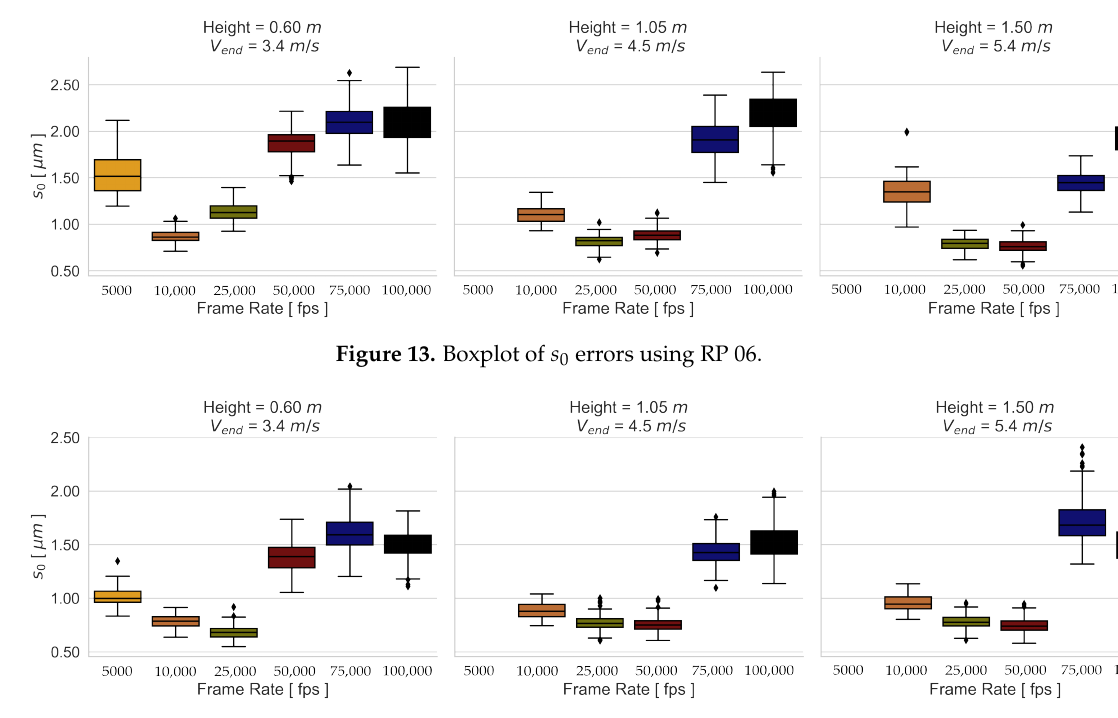
Figure 14. Boxplot of s 0 errors using SP 02.